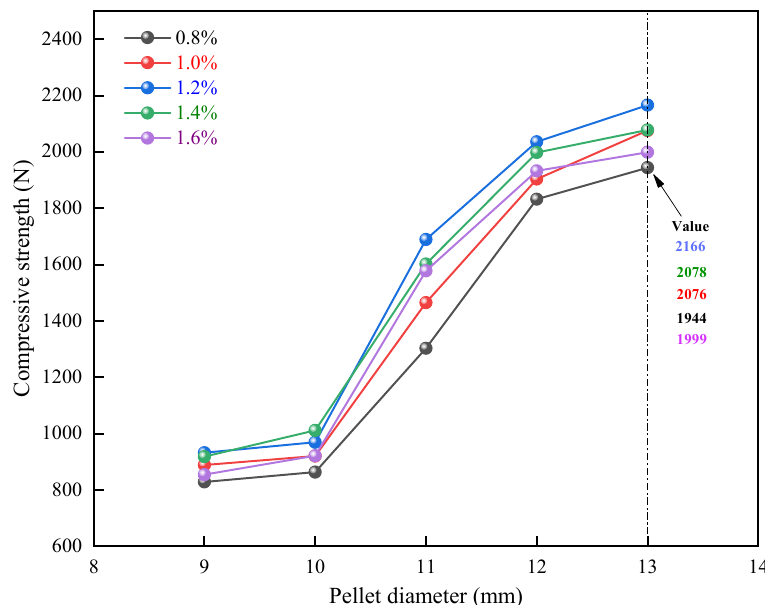
Figure 9. Effect of pellet diameter on the compressive strength of pellets.